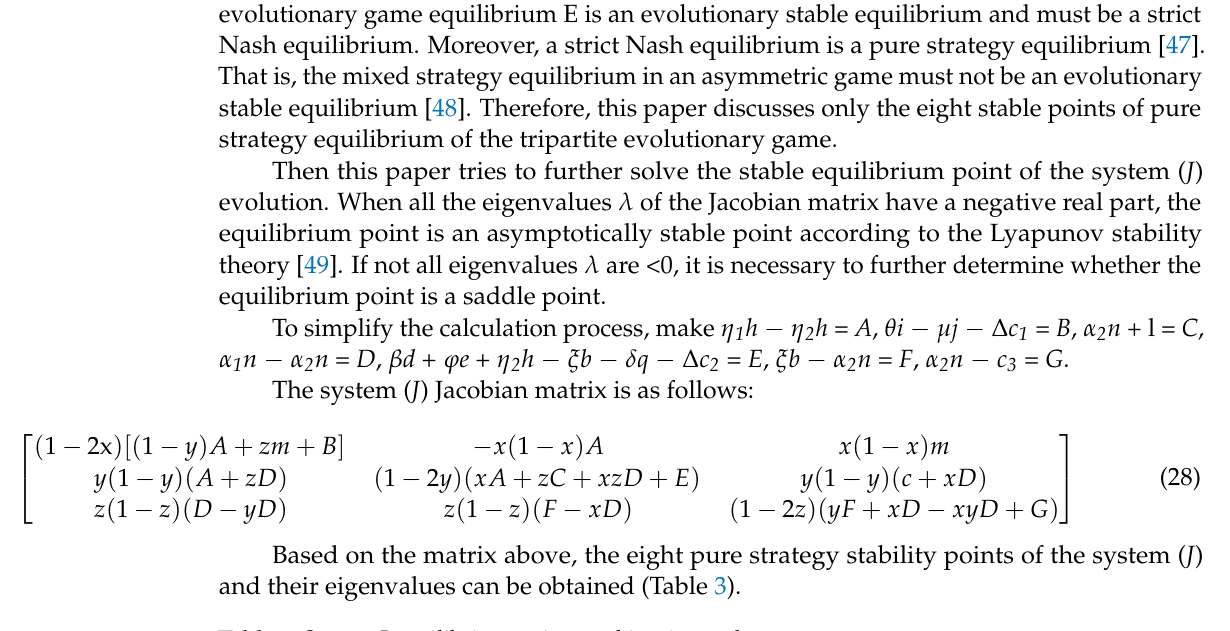
Table 3. System J equilibrium points and its